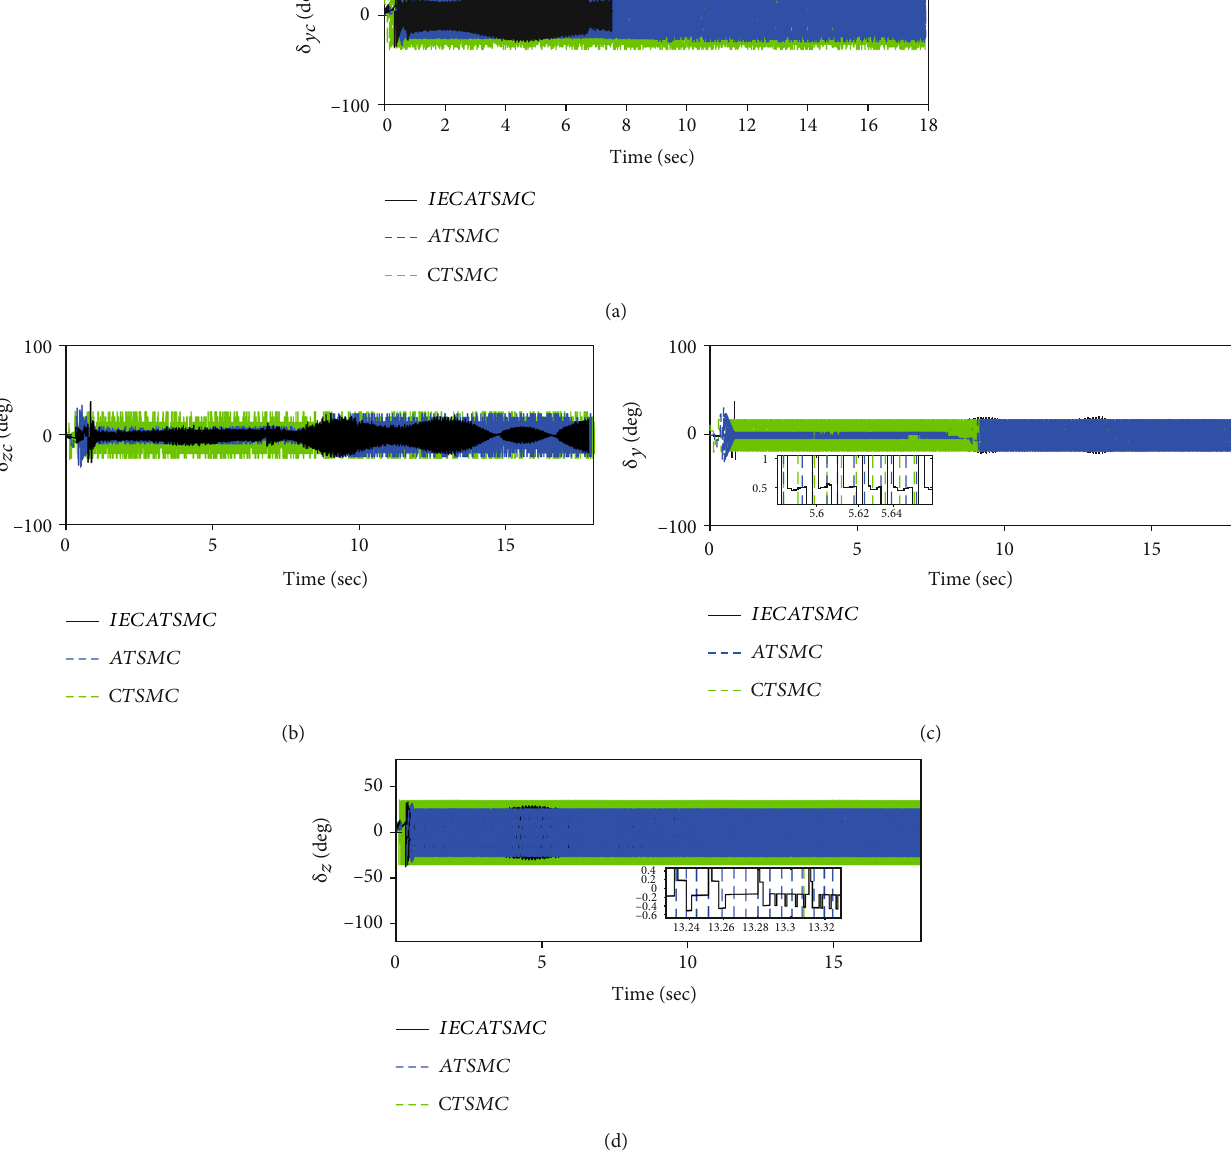
Figure 6: Equivalent canard angle